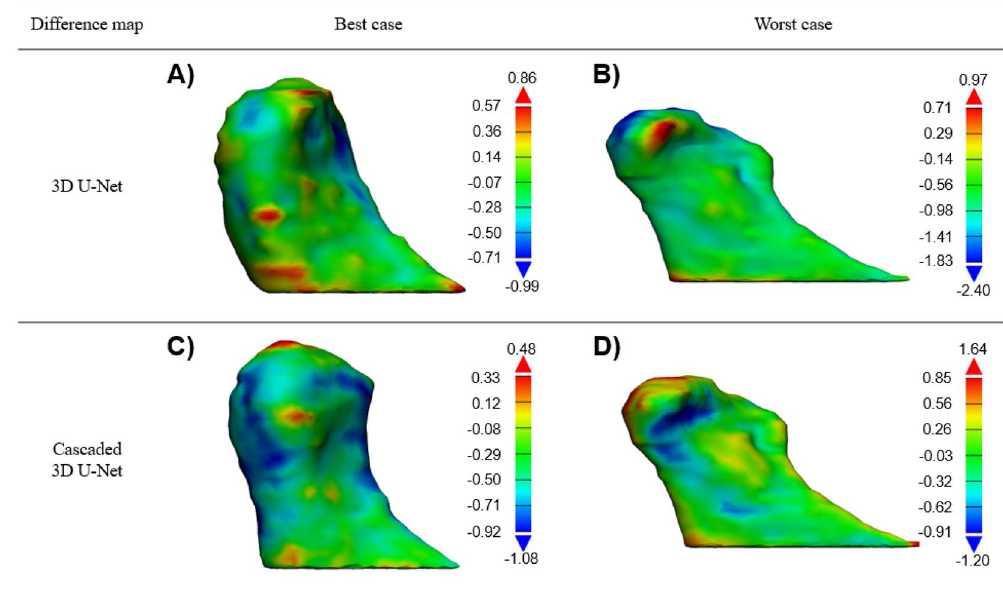
Figure 4. Difference map between ground truth and prediction in basic 3D U-Net and cascaded 3D. U-Net. ( A ) Best case (error range, − 0.99–0.86 mm) and ( B ) worst case (error range, − 2.40–0.97 mm) of basic 3D U-Net. ( C ) Best case (error range, − 0.48–1.08 mm) and ( D ) worst case (error range − 1.20–1.64 mm) of cascaded 3D